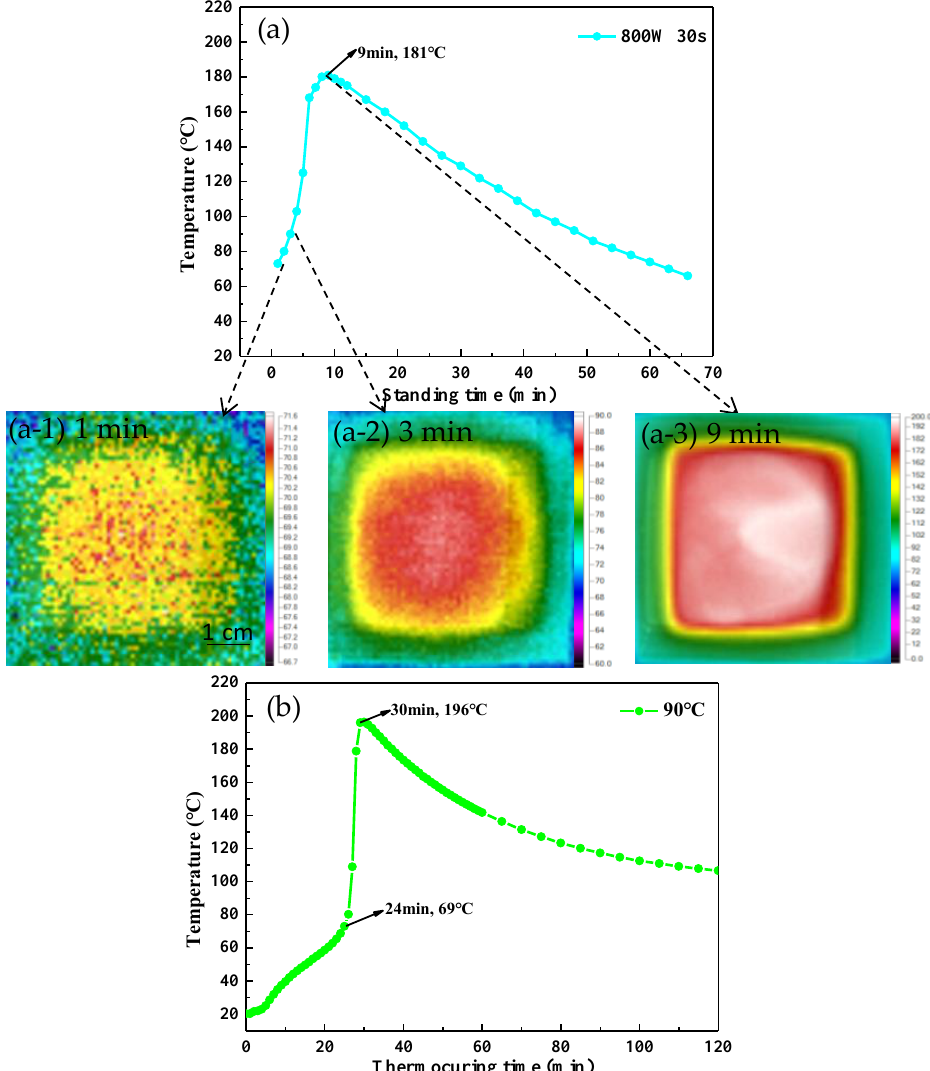
Figure 4. ( a ) Temperature of the UPR sample with increasing standing time after microwave irradiation under 800 W for 30 s. ( b ) Temperature of the UPR sample with a thermocuring time at 90 °C for 120 min.